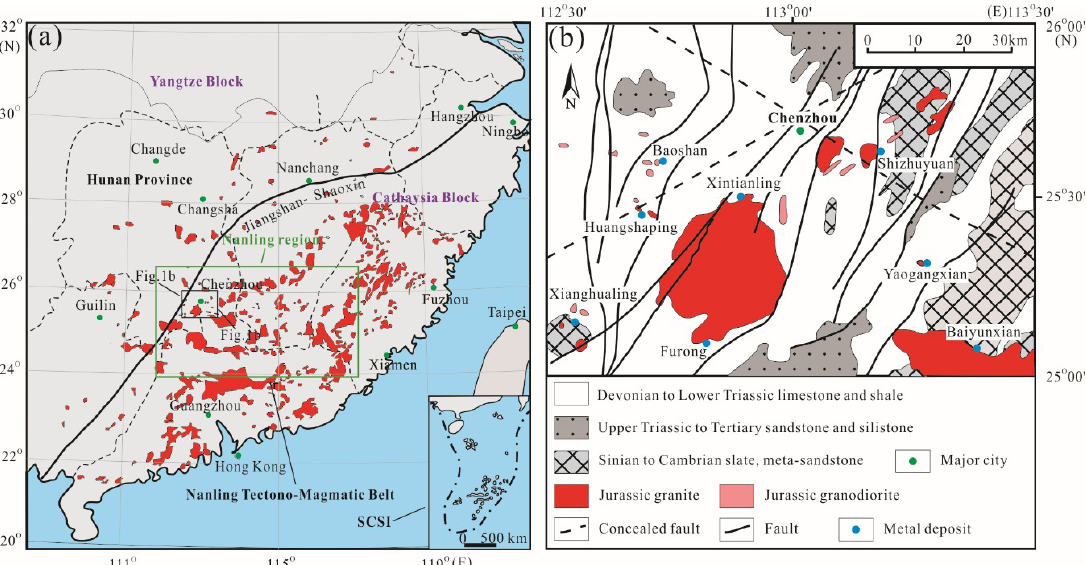
Figure 1. Regional geological map. ( a ) Simplified geological sketch map showing the distribution of Jurassic granitoids in South China (after [24]); ( b ) Geological sketch map of W–Sn polymetallic deposits in the central Nanling Range, southern Hunan (modified from [22]).